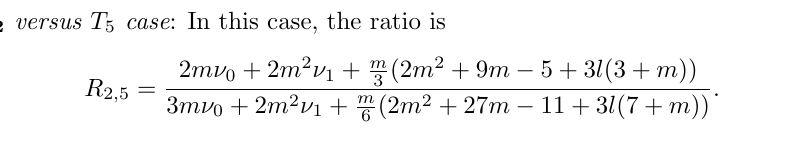
Figure 7. Boundary lines for comparison of T 2 and T 3 .